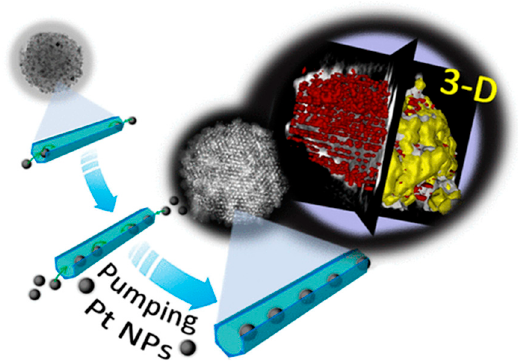
Figure 65. Pt nanoparticles pumped within the channels of the magnetic MCM-41 nanospheres. Reproduced with permission from [171]. Copyright 2017 American Chemical Society.